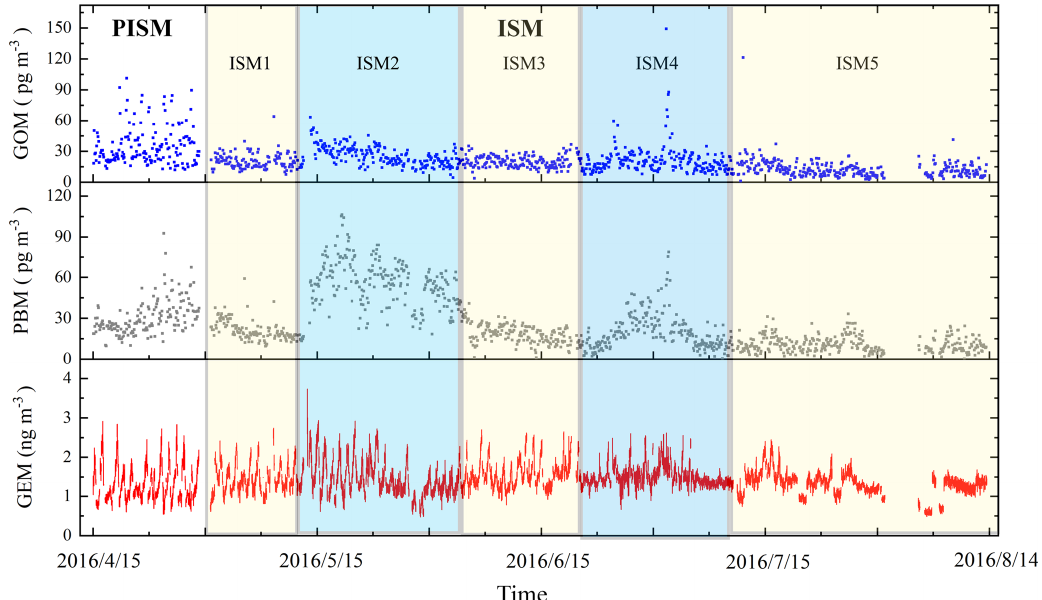
Figure 2. Time series change of GEM, GOM and PBM concentrations during the study period. The time series was split into a pre-Indian summer monsoon (PISM) period and five Indian summer monsoon (ISM) periods as follows: 15–30 April 2016 (PISM), 1–12 May (ISM1), 13 May–4 June (ISM2), 5–20 June (ISM3), 21 June–10 July (ISM4) and 11 July–14 August